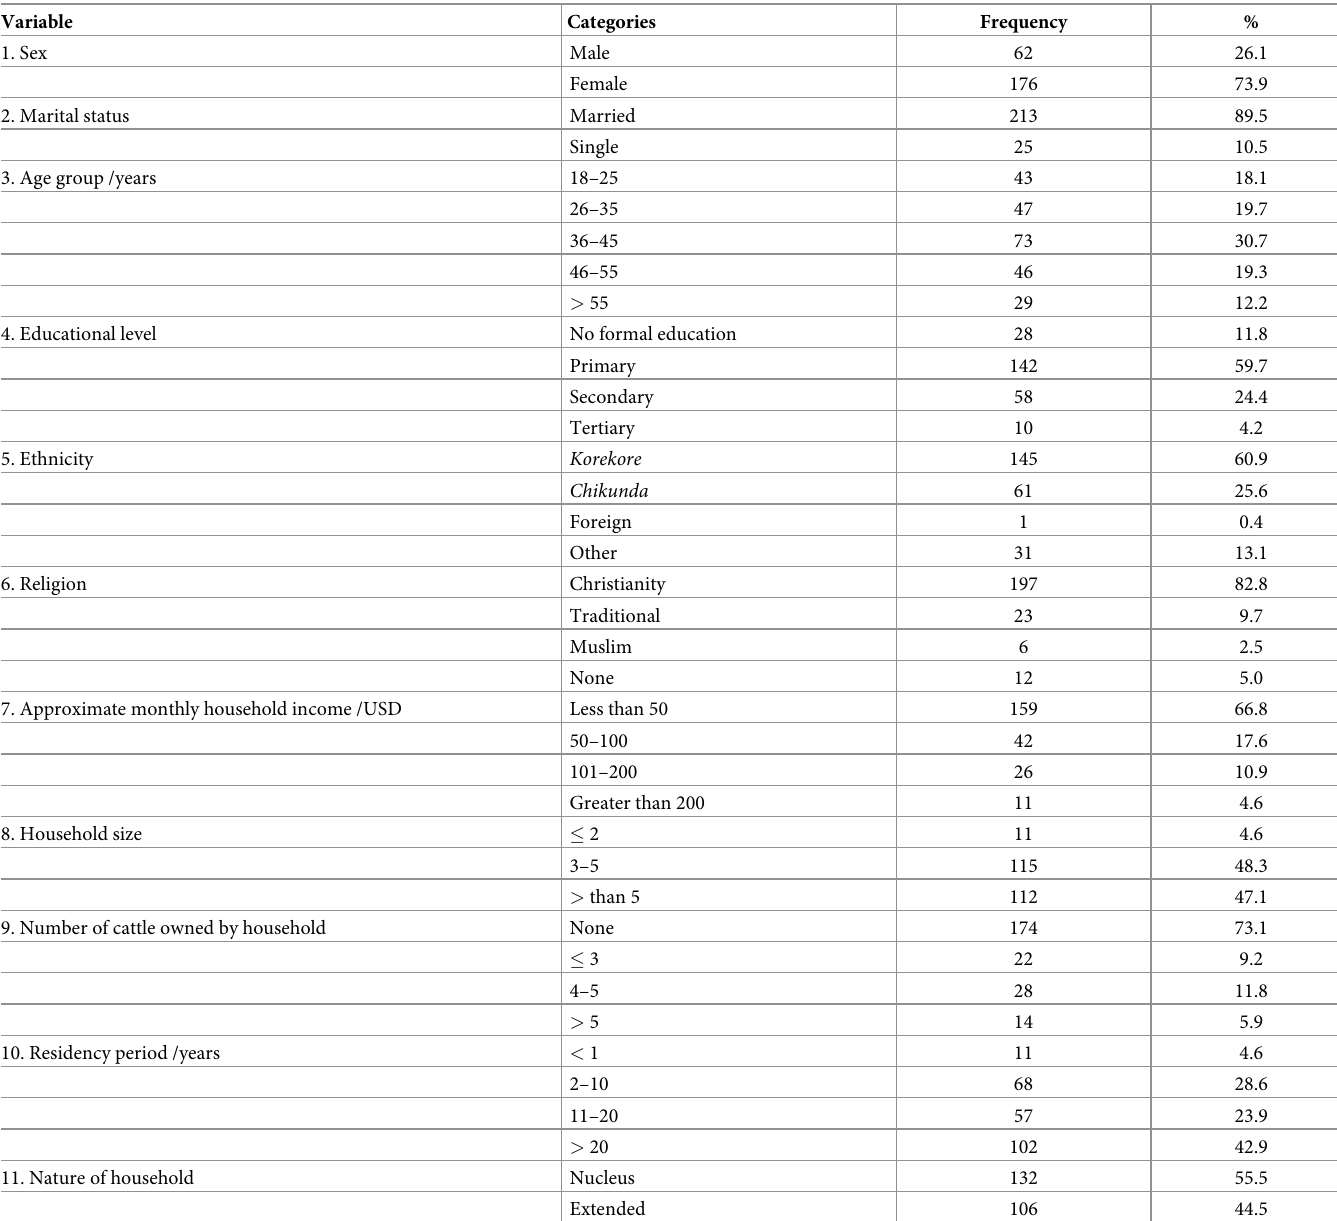
Table 1. Demographic characteristics of respondents at households with BVIP latrines, Mbire district, northern Zimbabwe, 2021 ( n = 238).